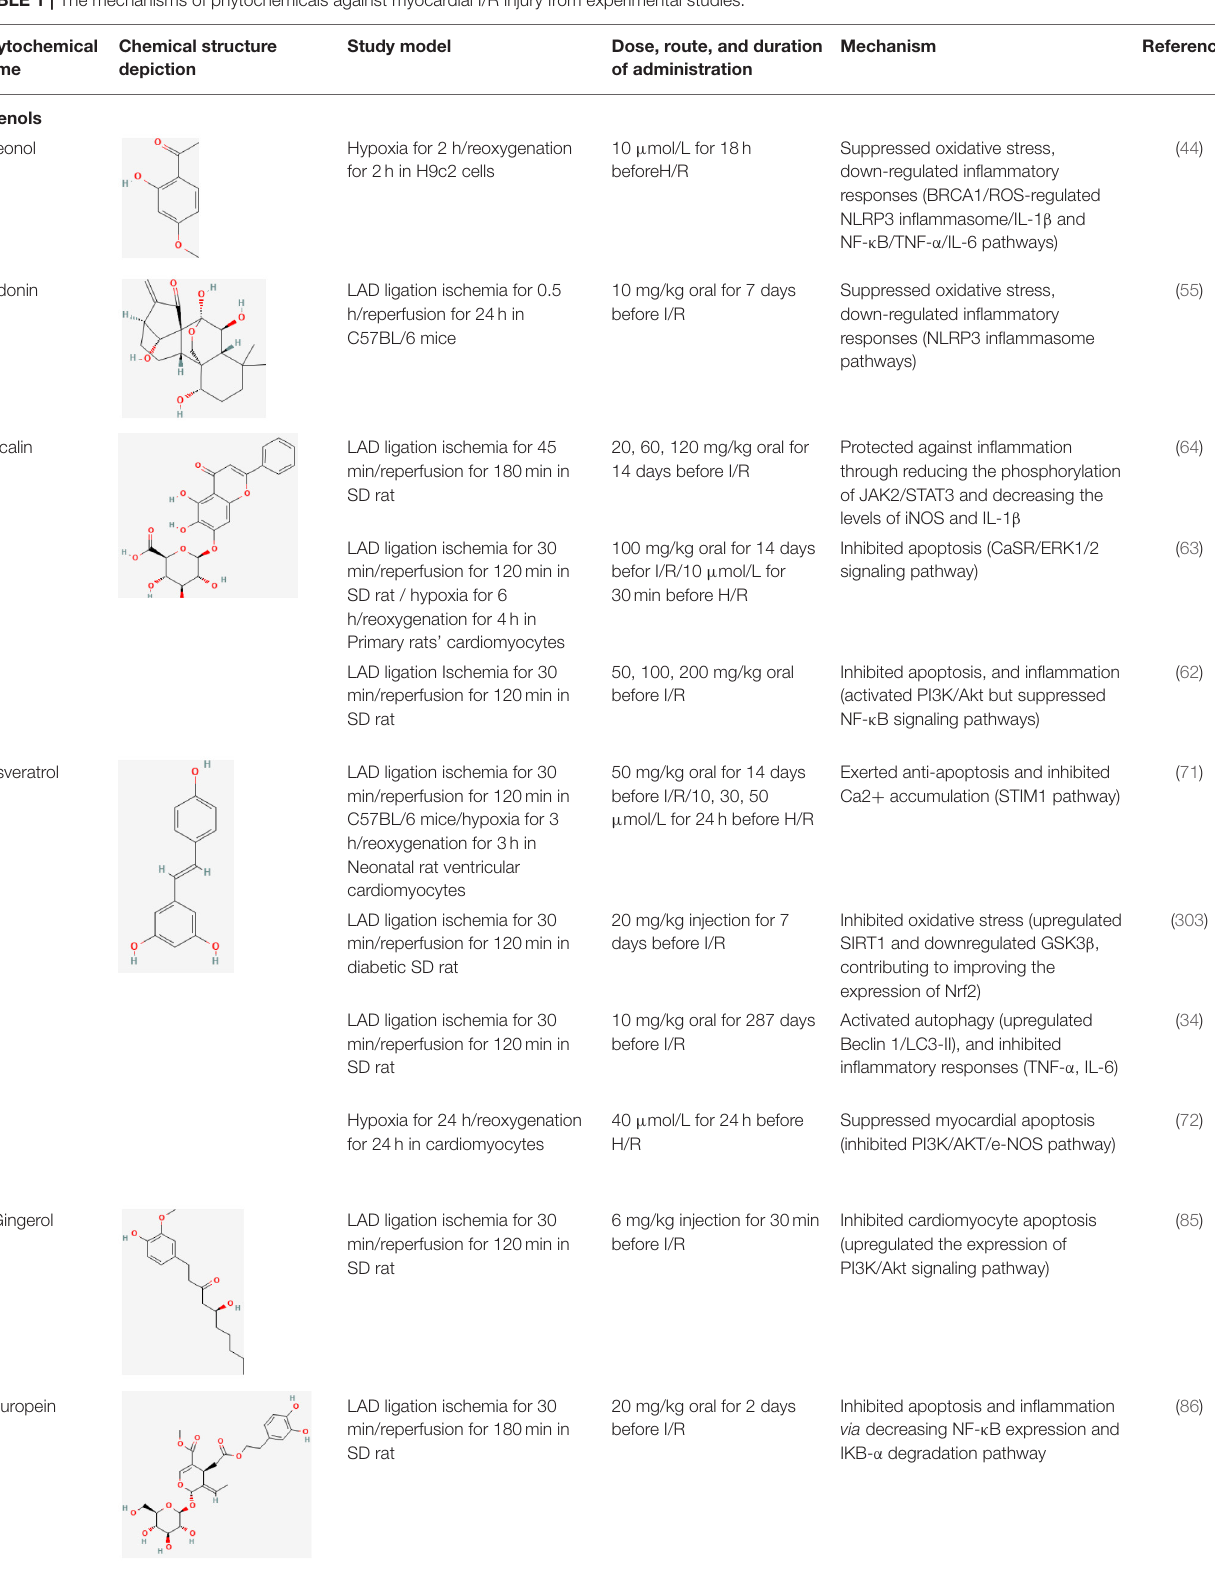
TABLE 1 | The mechanisms of phytochemicals against myocardial I/R injury from experimental studies. Phytochemical